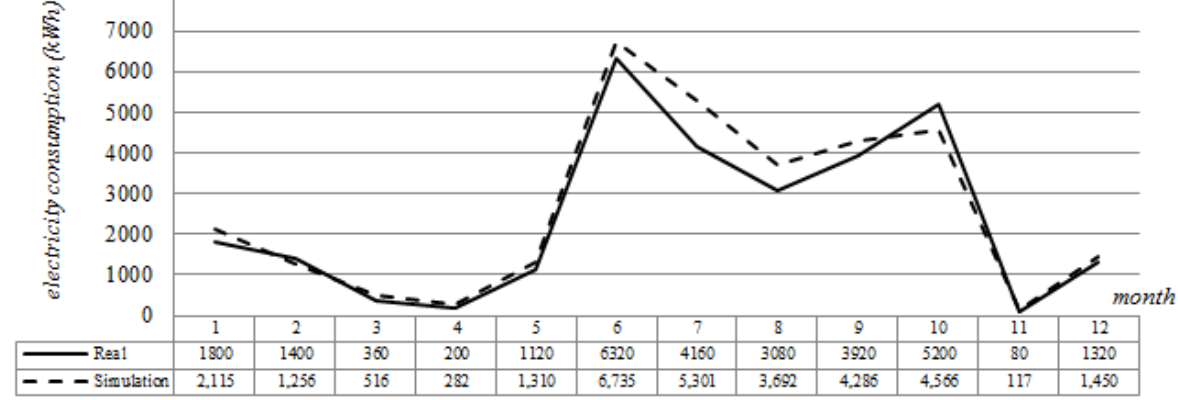
Figure 3. (CV)RMSE: electricity consumption of heat pump (“Y”university gym